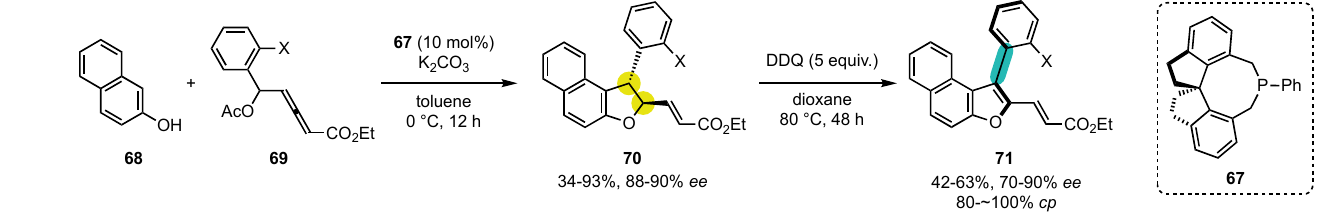
Scheme 18. Enantioselective synthesis of atropisomeric 3 ‐ arylfurans using a phosphine ‐ catalyzed annulation step. annulation step.